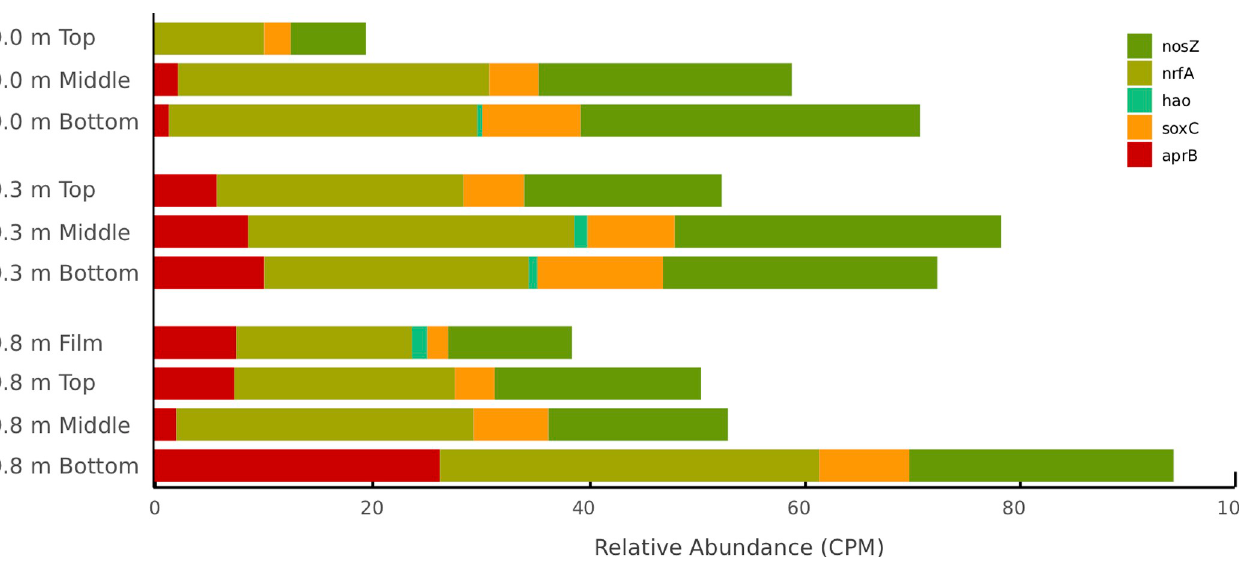
pseudopristleyi dominates these samples [22,23]. The high population density of this organism likely explains the disproportionate representation of psbA .